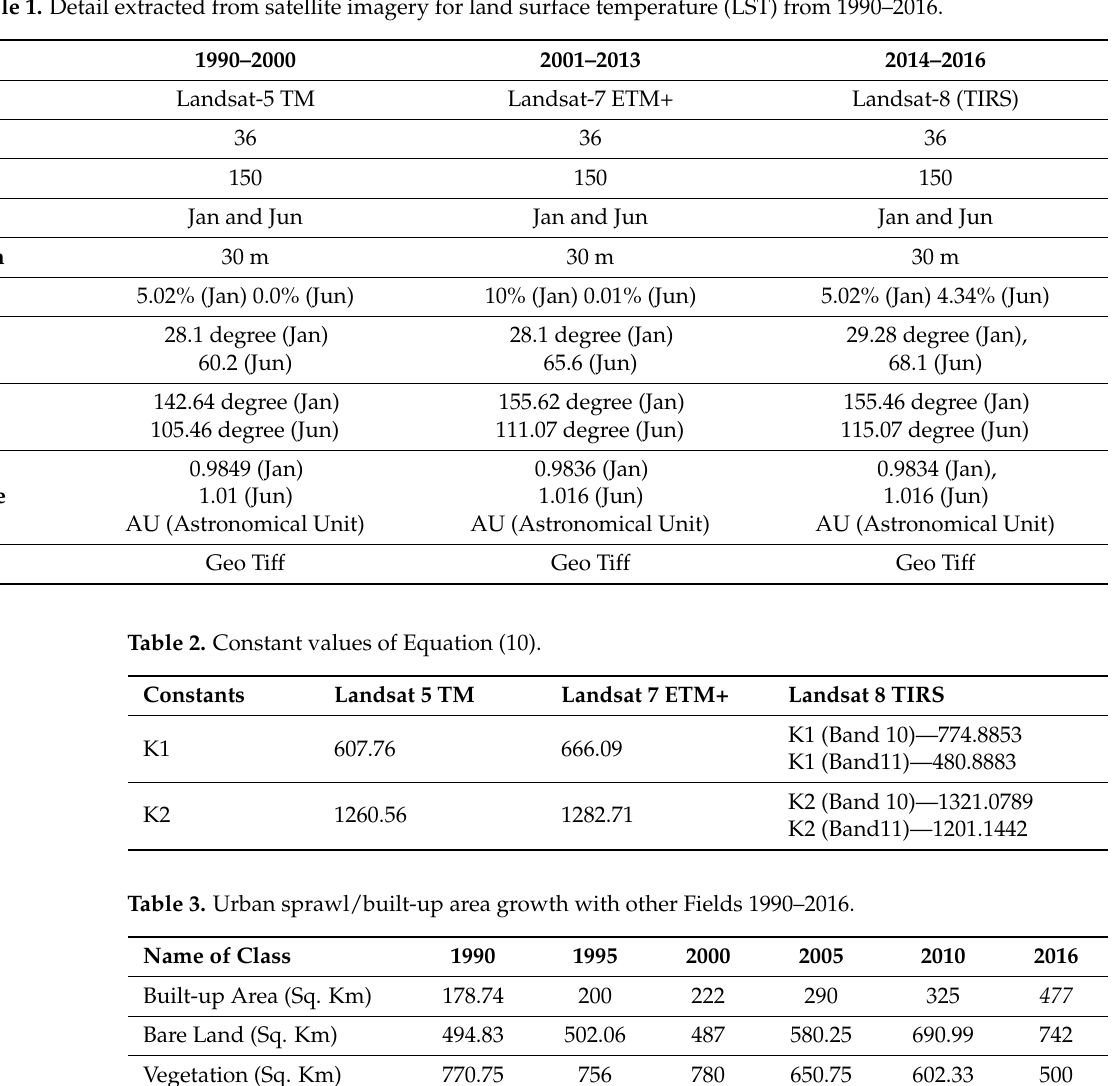
Table 1. Detail extracted from satellite imagery for land surface temperature (LST) from 1990–2016.